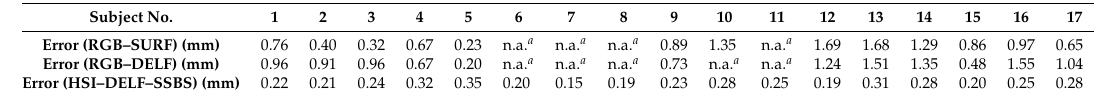
Figure 10. DELF correspondences after RANSAC geometric verification for subject no. 3 in the RGB-transformed image. Table 3. Results of 2D mean error per subject for all the detected skin features using RGB-transformed images. For a better comparison, the results found when HSI images are used and the DELF algorithm is applied after the SSBS band selection are